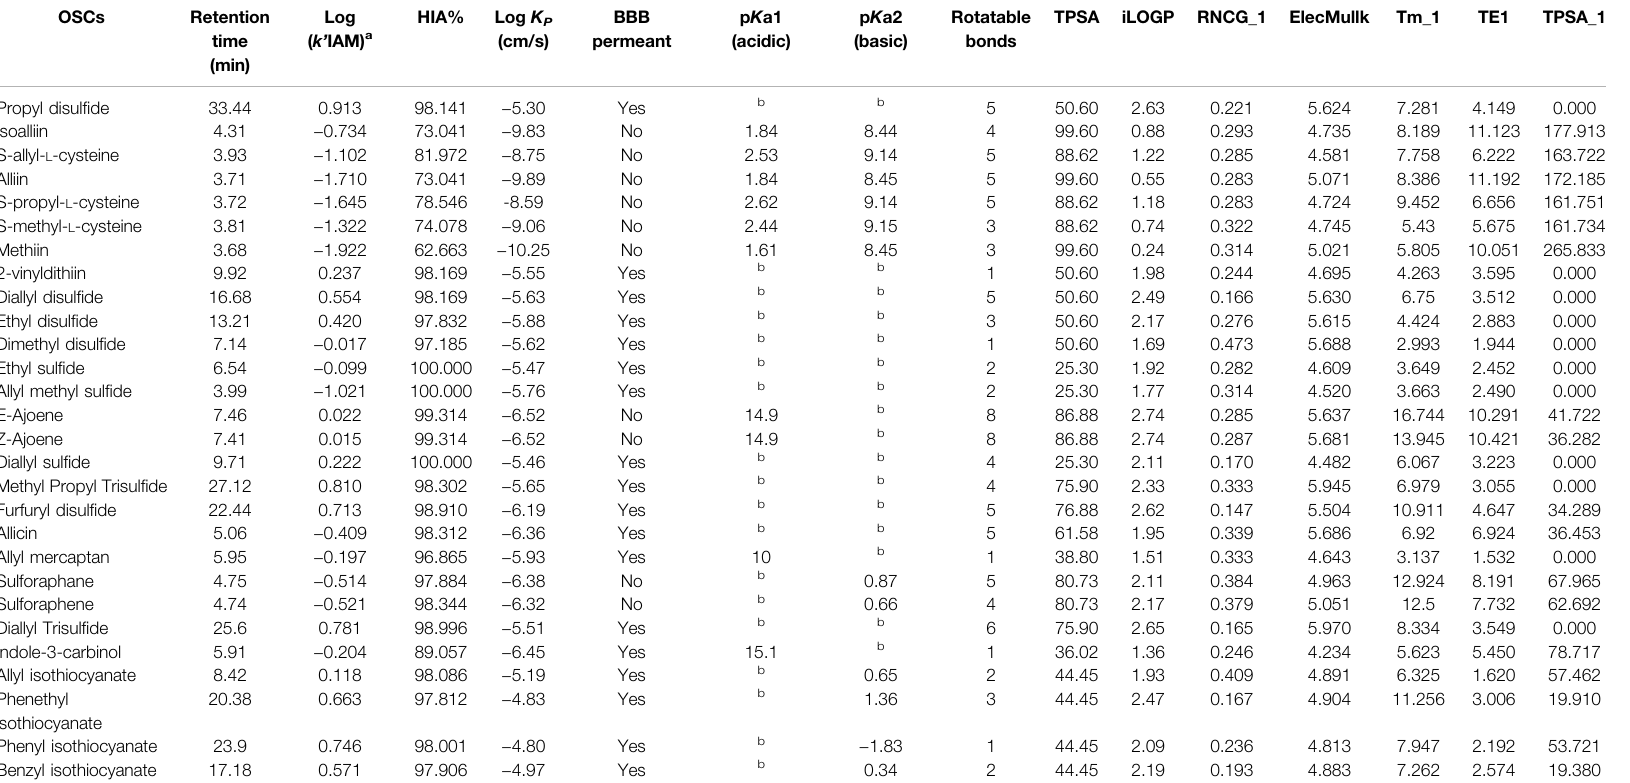
a For an explanation of the symbols, refer to the text. b Nonionizable